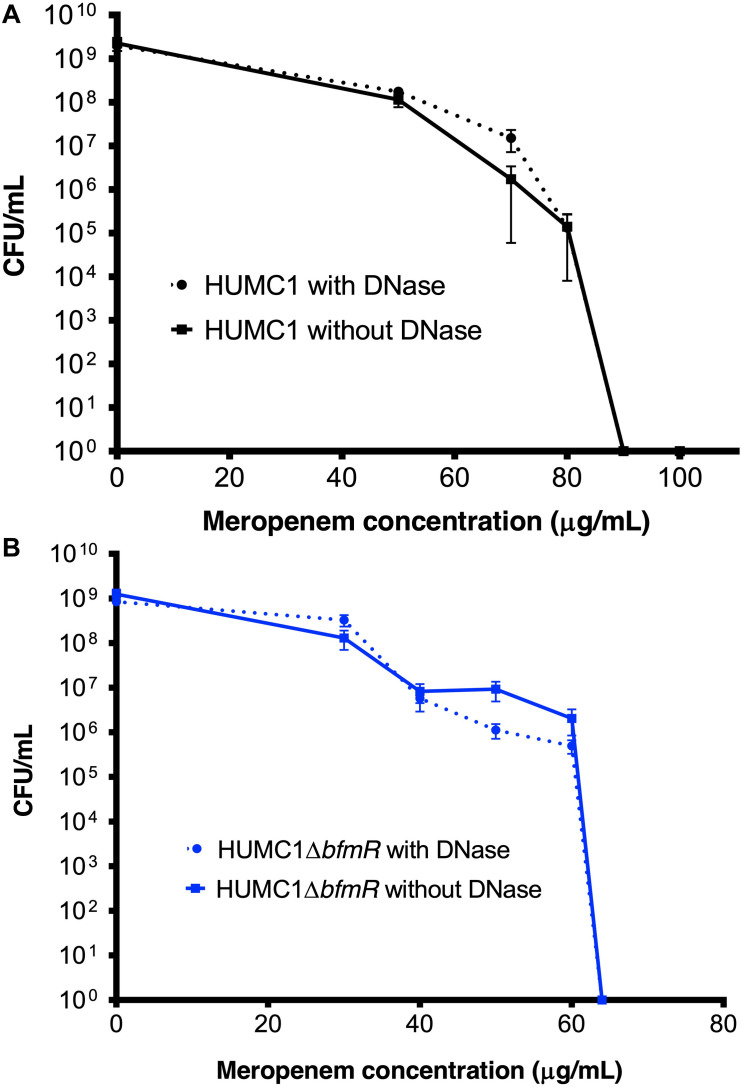
(A) Comparison of the growth/survival of HUMC1 with and without 10 U/mL DNase in Mueller Hinton II cation-adjusted broth in various concentrations of meropenem (0–100 μg/mL) after 24 h incubation at 37°C. (B) Comparison of the growth/survival of HUMC1ΔbfmR with and without 10 U/mL DNase in Mueller Hinton II cation-adjusted broth in various concentrations of meropenem (0–60 μg/mL). Data are means ± SEM, n = 6, P = 0.3669, and P = 0.9343, respectively, with comparisons of log-transformed AUC by unpaired t test.